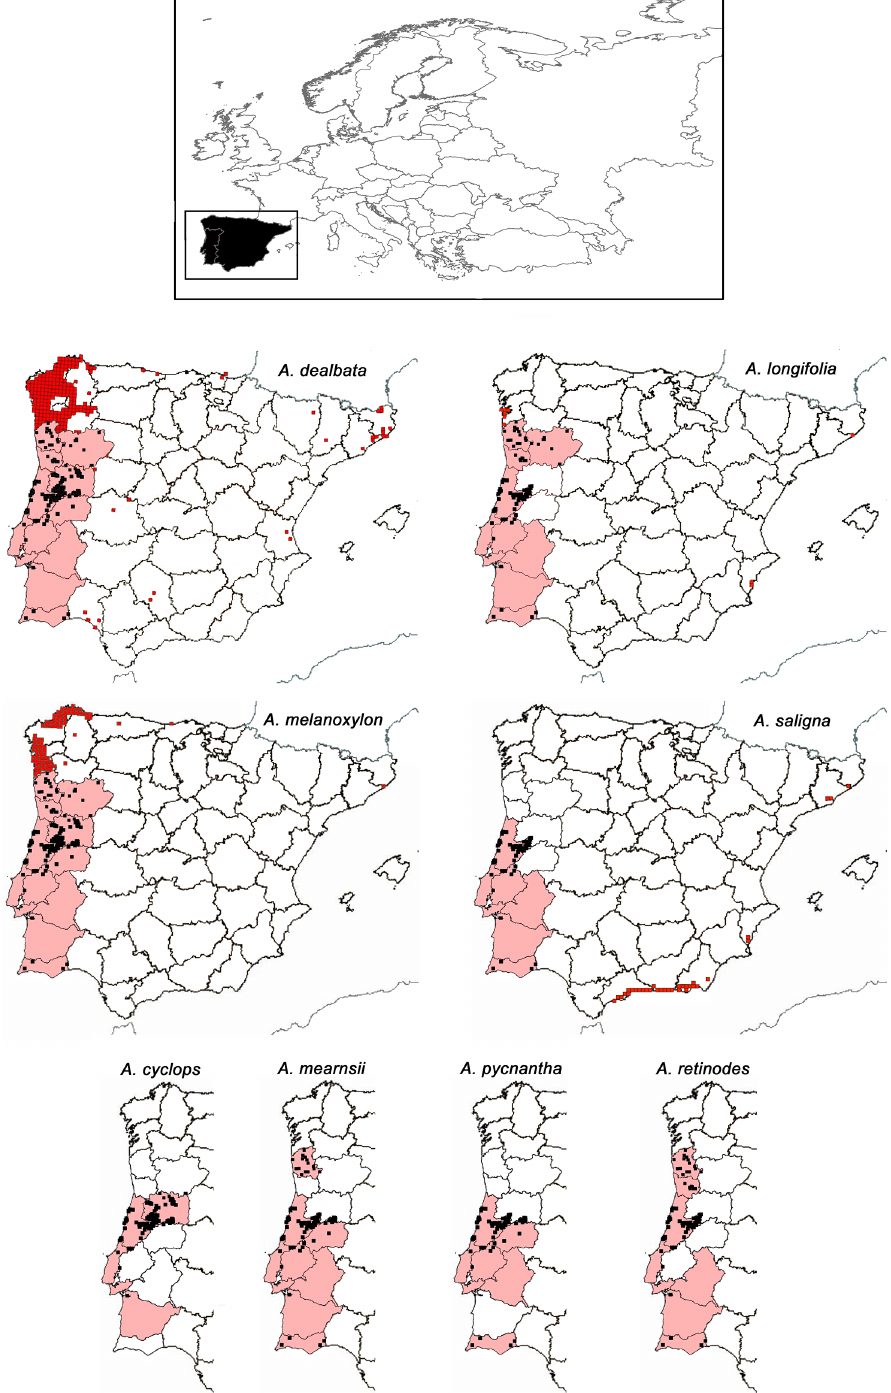
Figure 1. Distribution of invasive Australian Acacia species in the Iberian Peninsula. Data of the distribution of each Acacia species in Spain (10km × 10km UTM red squares) are taken from Sanz-Elorza et al. (2004). For Portugal we did not find published such detailed information at a species level; therefore, for a given species its presence–absence data per province (invaded provinces in pink; adapted from Invasive Plants in Portugal, 2019) are combined with data of Acacia genus presence on a more detailed scale (10km × 10km black squares; adapted from Fernandes et al., 2013). At the top of the figure is a map of Europe with the Iberian Peninsula (continental Portugal and Spain) highlighted in